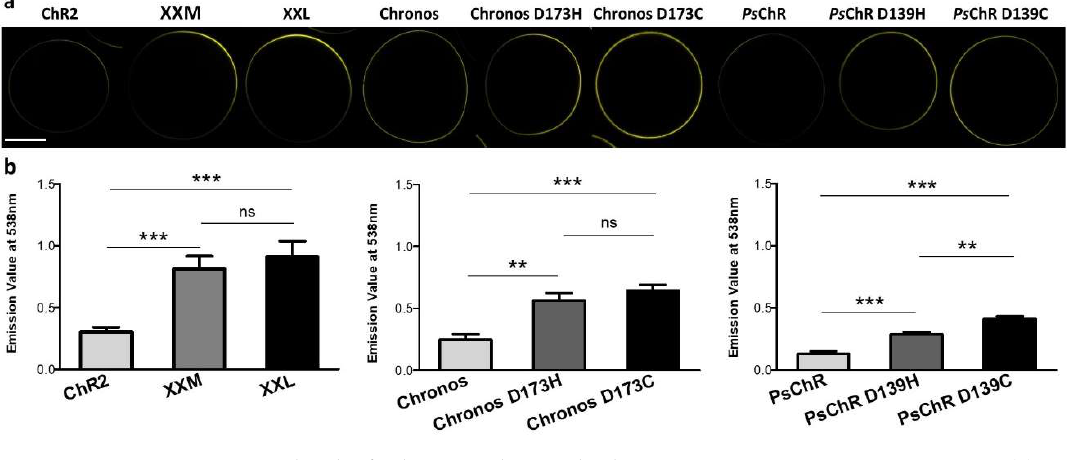
Figure A1. Expression level of ChR2, Ps ChR, and Chronos variants in Xenopus oocyte. ( a ) Representative confocal images of all the constructs, scale bar = 500 µm. ( b ) Yellow fluorescent protein (YFP) fluorescence emission values from oocytes expressing different channelrhodopsins. Data was shown as mean ± SEM, n = 5–6. Pictures and fluorescence emission values were taken and measured 2 days after 20 ng cRNA injection. Sequence alignment of ChR2, Chronos, and Ps ChR. Conserved cysteine and aspartate of the DC gate were marked in the red box.